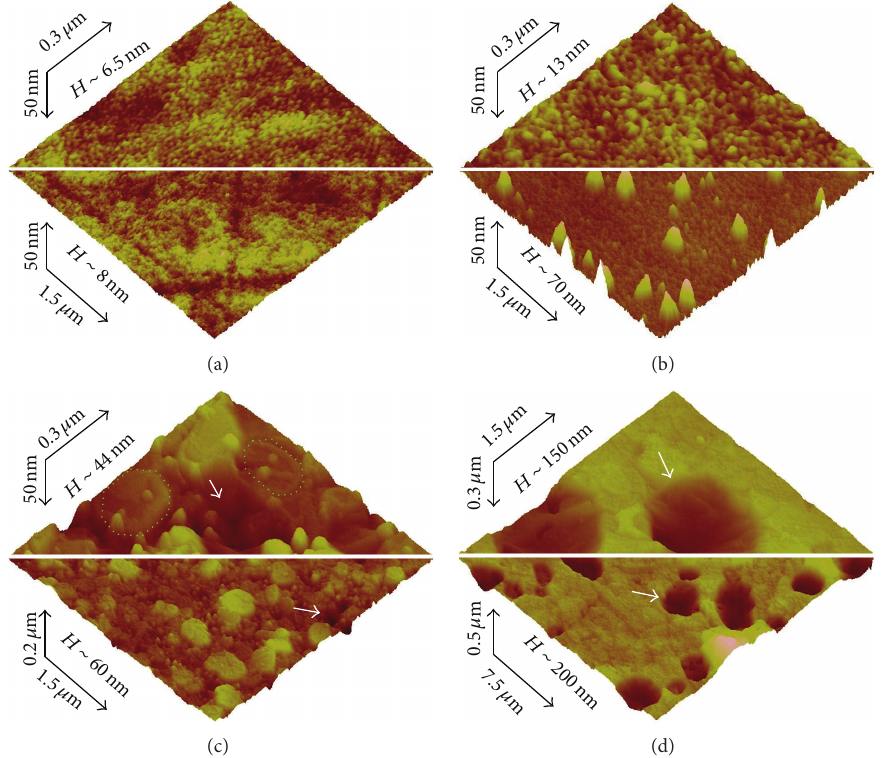
Figure 6: AFM images of surface topology of Ni 2 Si/ n -SiC contacts before (a) and after annealing at 600 ∘ C (b), 1050 ∘ C (c), and 1100 ∘ C (d). 𝐻 : surface heights